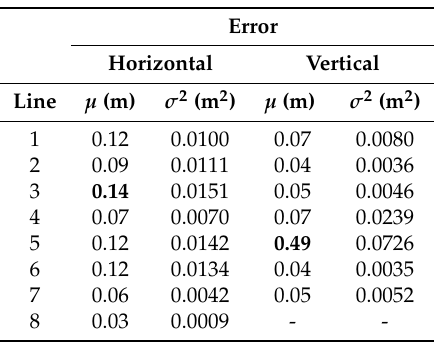
Table 1. Power line estimated model